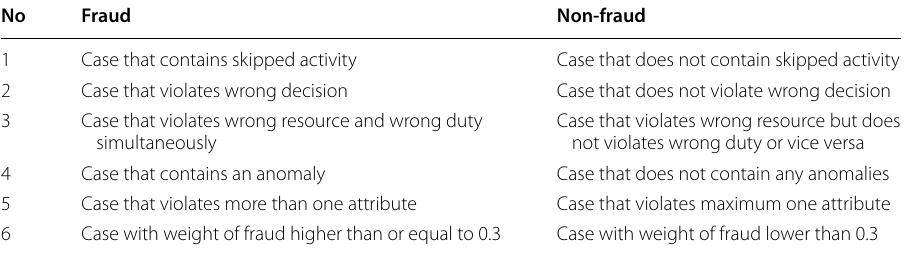
Table 13 Expert assessment for determining anomaly for ARL and fuzzy ARL training